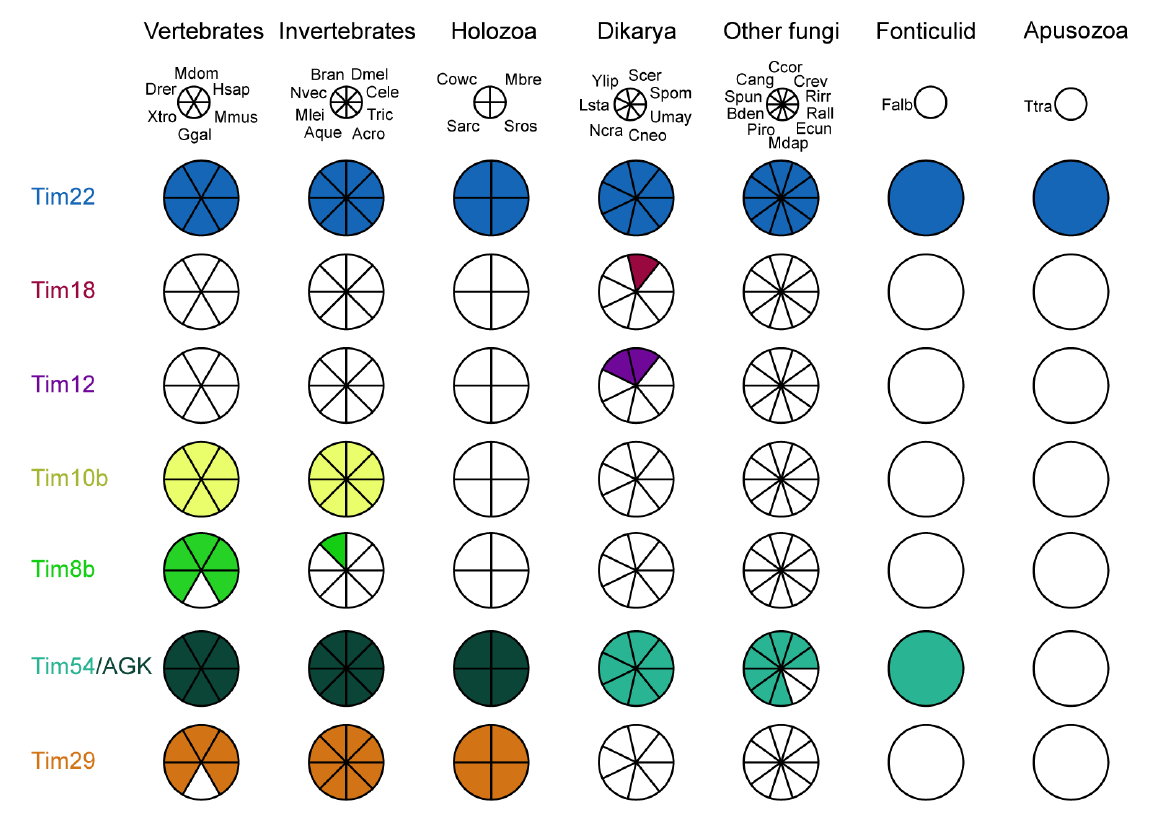
Figure 1. Distribution of TIM22 complex components across eukaryotes. The Coulson plot was generated using the Coulson Plot Generator (Field et al. , 2013). Abbreviations: Vertebrates : Hsap, Homo sapiens; Mdom, Monodelphis domesticus ; Drer, Danio rerio ; Xtro, Xenopus tropicalis ; Ggal, Gallus gallus ; Mmus, Mus musculus ; Invertebrates: Dmel, Drosophila melanogaster ; Cele, Caenorhabditis elegans ; ; Tric, Trichoplax sp .; Acro, Acropora sp . ; Aque, Amphimedon queenslandica ; Mlei, Mnemiopsis leidyi ; Nvec, Nematostella vectensis ; Bran, Branchiostoma sp.; Unicellular Holozoa : Mbre, Monosiga brevicollis ; Cowc, Capsaspora owczarzaki; Sarc, Sphaeroforma arctica ; Sros, Salpingoeca rosetta ; Fungi : Spom, Schizosaccharomyces pombe ; Scer, Saccharomyces cerevisiae ; Ncra, Neurospora crassa ; Cneo, Cryptococcus neoformans ; Umay, Ustilago maydis ; Lsta, Lipomyces starkeyi ; Ylip, Yarrowia lipolytica , Bden, Batrachochytrium dendrobatidis ; Mdap, Mitosporidium daphnia ; Ecun, Encephalitozoon cuniculi ; Piro, Piromyces sp.; Spun, Spizellomyces punctatus ; Rirr, Rhizophagus irregularis ; Crev, Coemansia reversa ; Ccor, Conidiobolus coronatus ; Cang, Catenaria anguillulae ; Rall, Rozella allomyces ; Fonticulids : Fonticula alba ; Apusozoa : Ttra, Thecamonas trahens